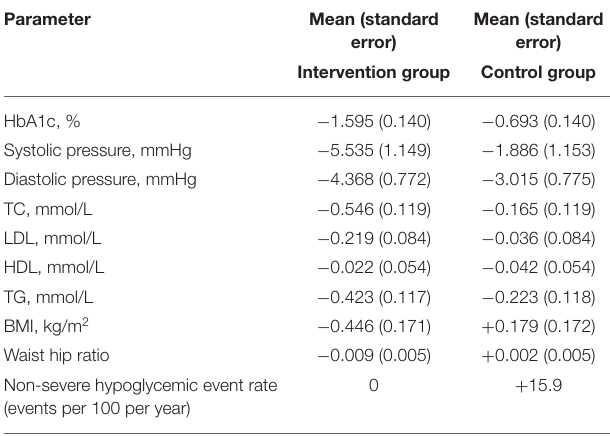
TABLE 2 | Changes in clinical effects (12